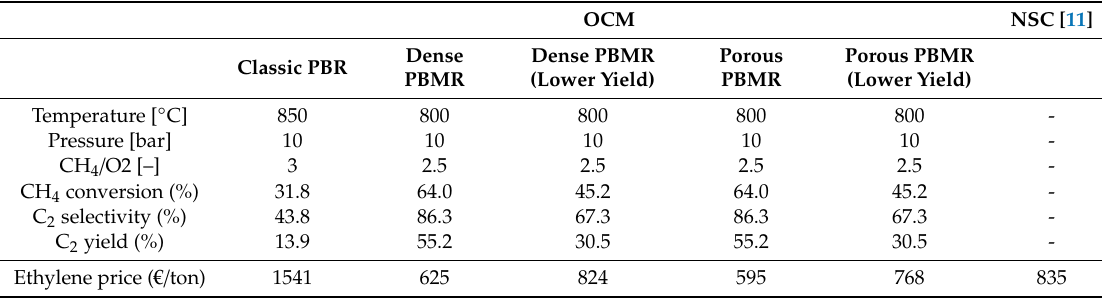
Table 7. Main parameters of the di ff erent OCM configurations and the naphtha steam cracking (NSC) considered to carry out the economic